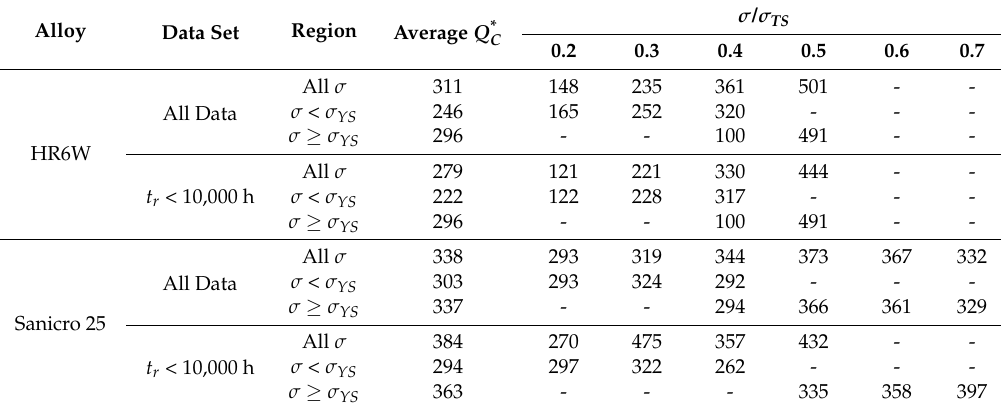
Table 2. Q ∗ values (kJ/mol) determined using Arrhenius plots. C